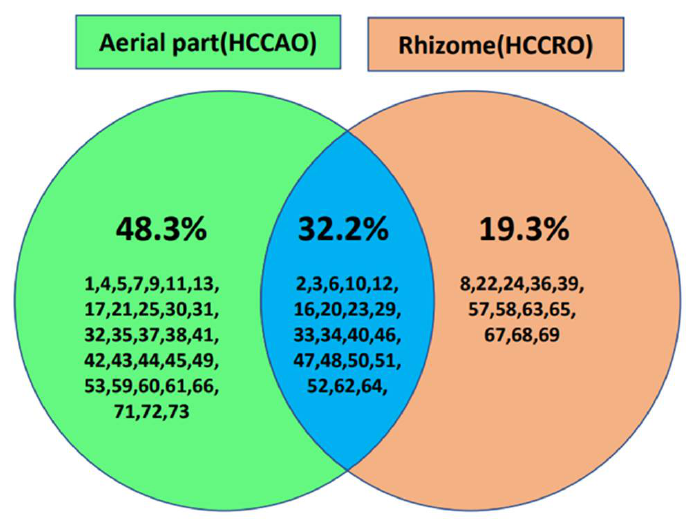
Figure 2. Venn diagram of essential oil composition of HCCAO and HCCRO (the chemical compositions were represented by different colors: HCCAO in green, HCCRO in orange, and common composition of both in blue).